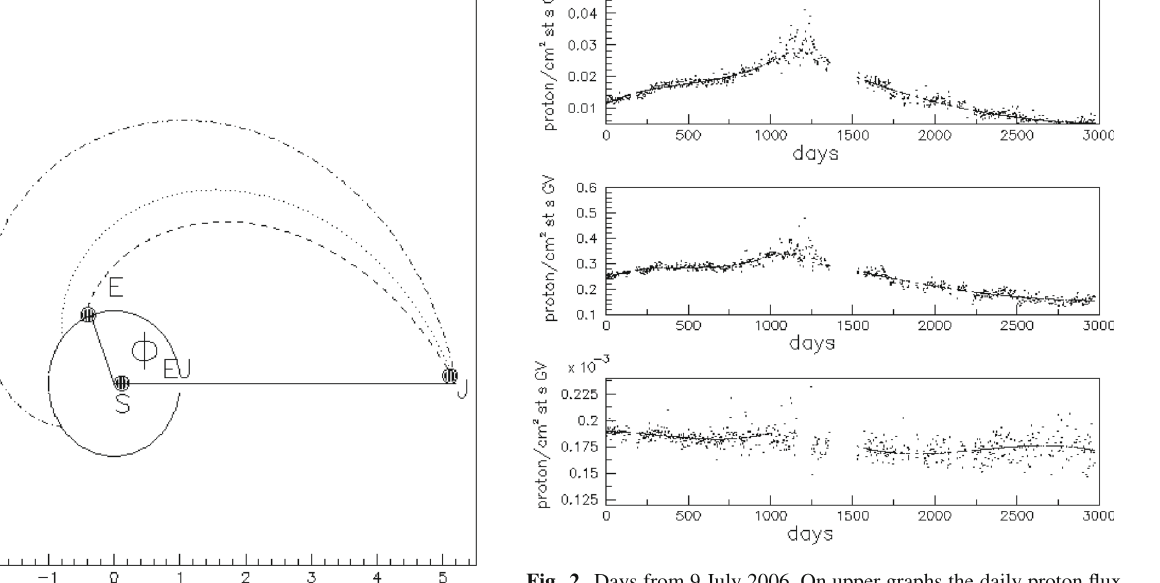
Fig. 2 Days from 9 July 2006. On upper graphs the daily proton flux (number of protons/ ( cm 2 sr s GV ) ) in the range 0.4-0.65 GV versus time (1865 fitted daily averages). In the middle one protons in the range 0.65–15 GeV (1866 fitted daily averages). In the lower one protons in the range 15–50 GeV (1809 fitted daily